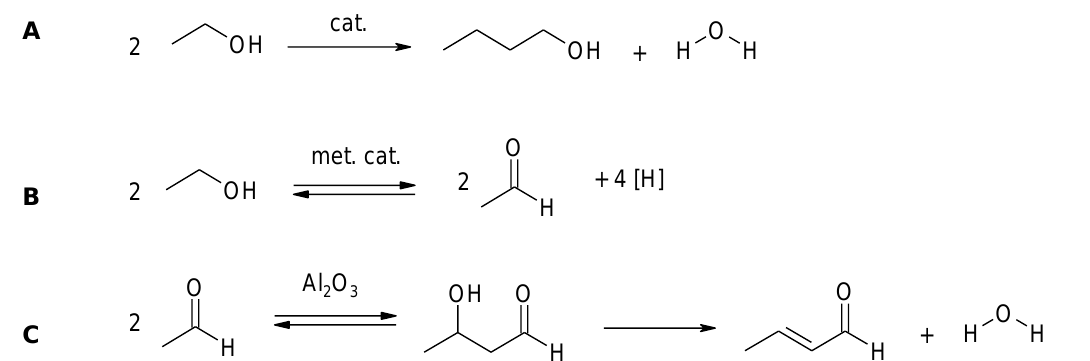
Figure 4. Condensation of bio-ethanol to butanol in the presence of catalysts ( A ) via concomitant elementary transformations ( B ) and ( C ).